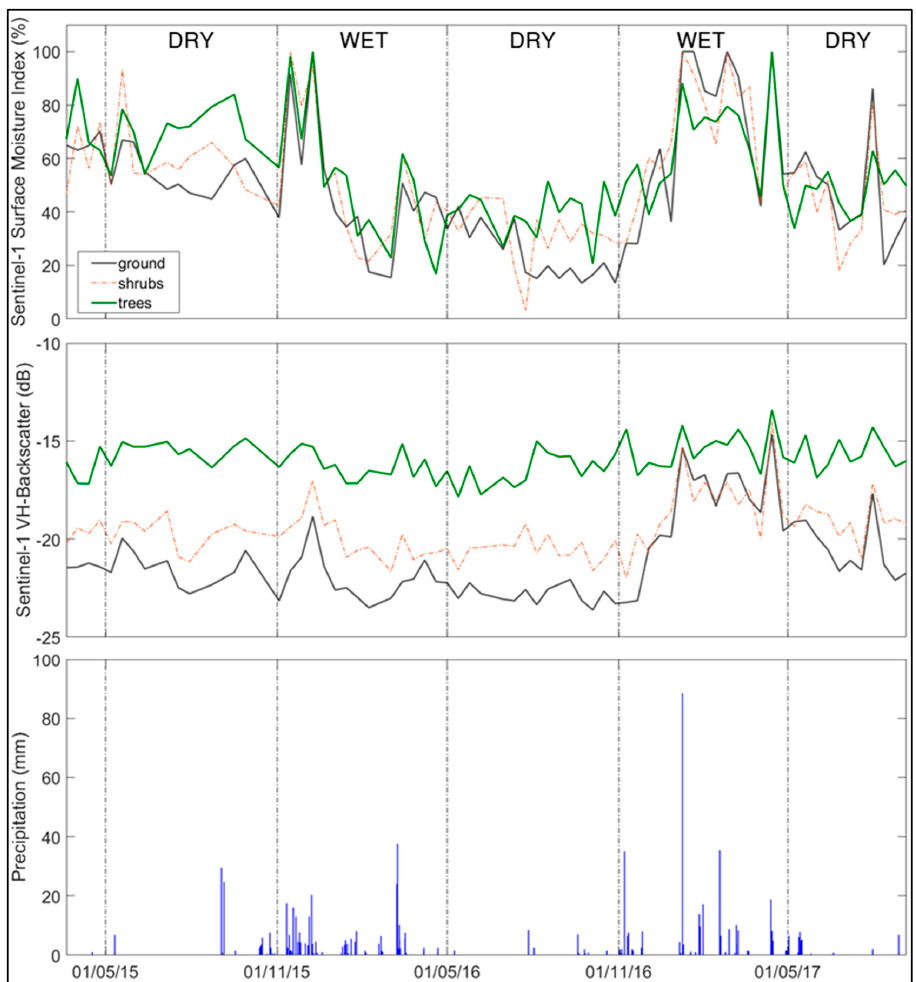
Figure 7. Time series of the Sentinel-1-derived SurfMI ( top ), Sentinel-1 VH backscatter information (dB) for the land cover classes trees, shrubs and ground ( middle ) as well as precipitation records ( bottom ).